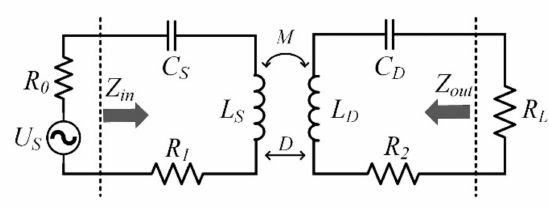
Figure 2. Equivalent circuit of WPT